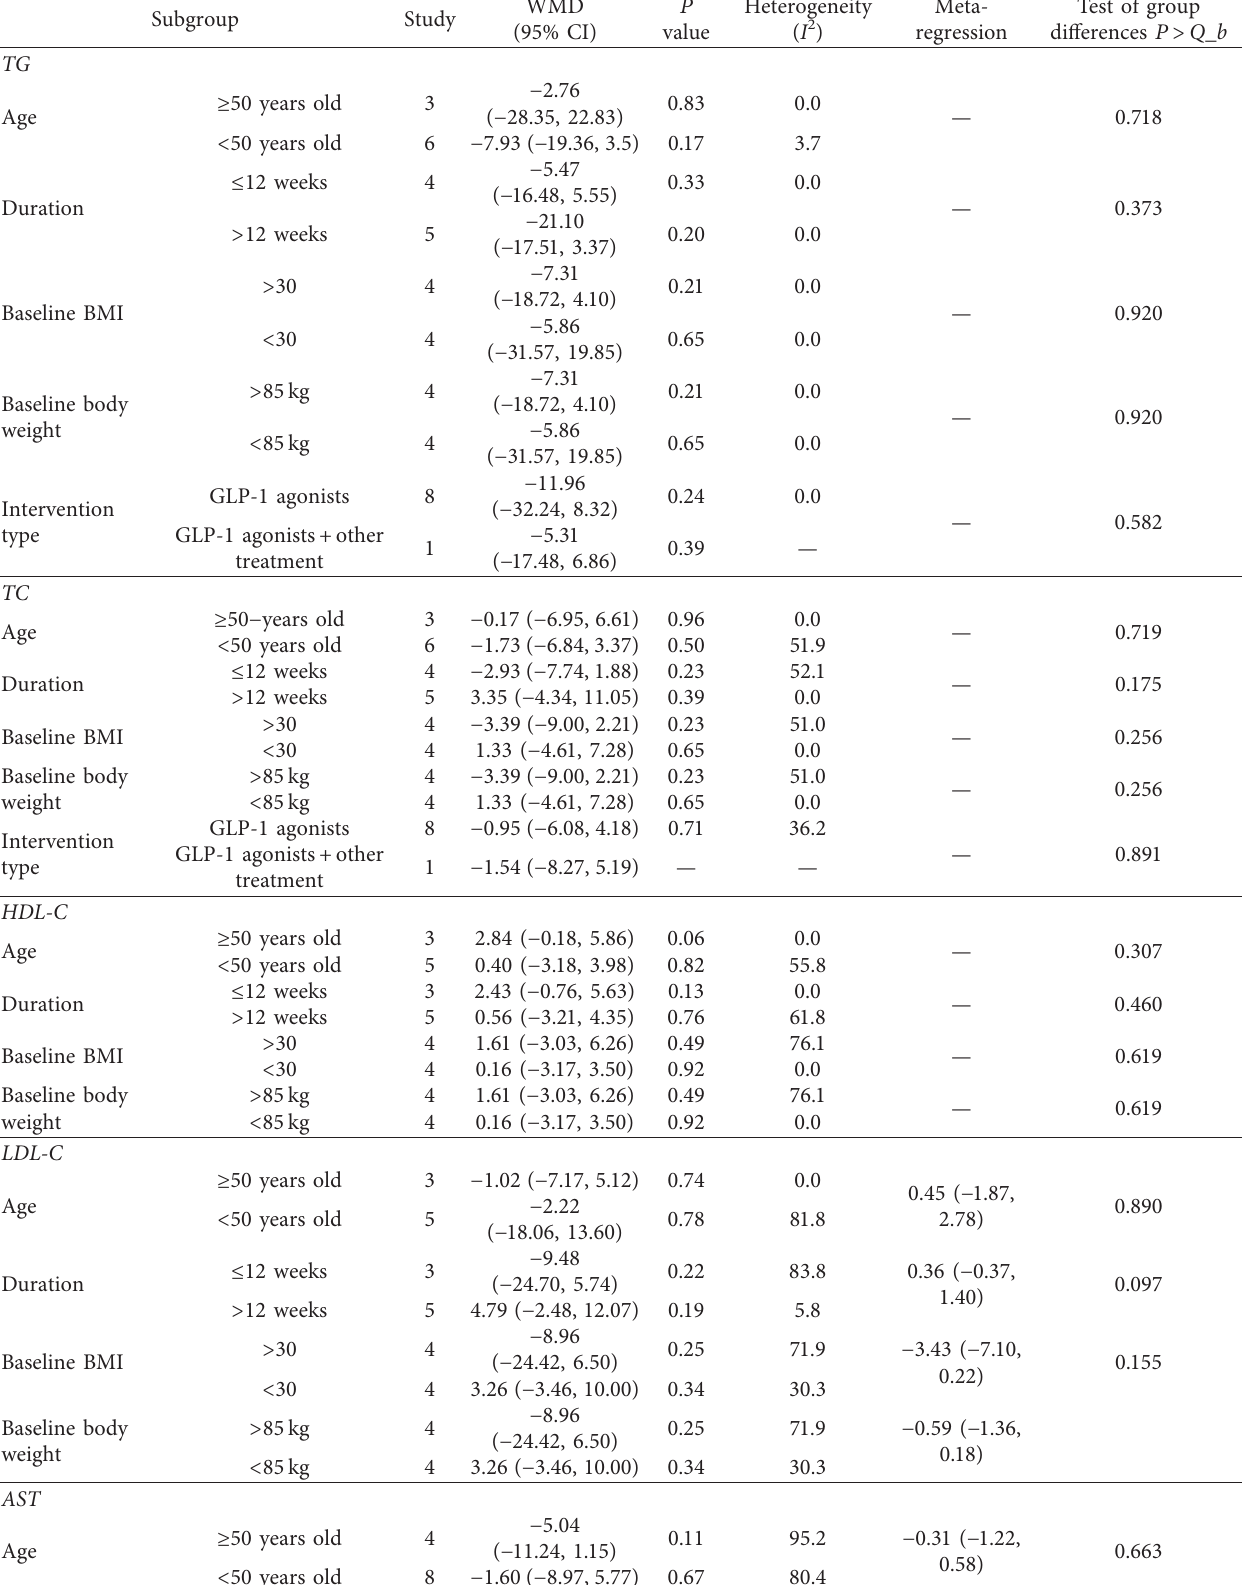
Table 3: The results of subgroup analysis for serum TC, TG, HDL-C, LDL-C, AST, and